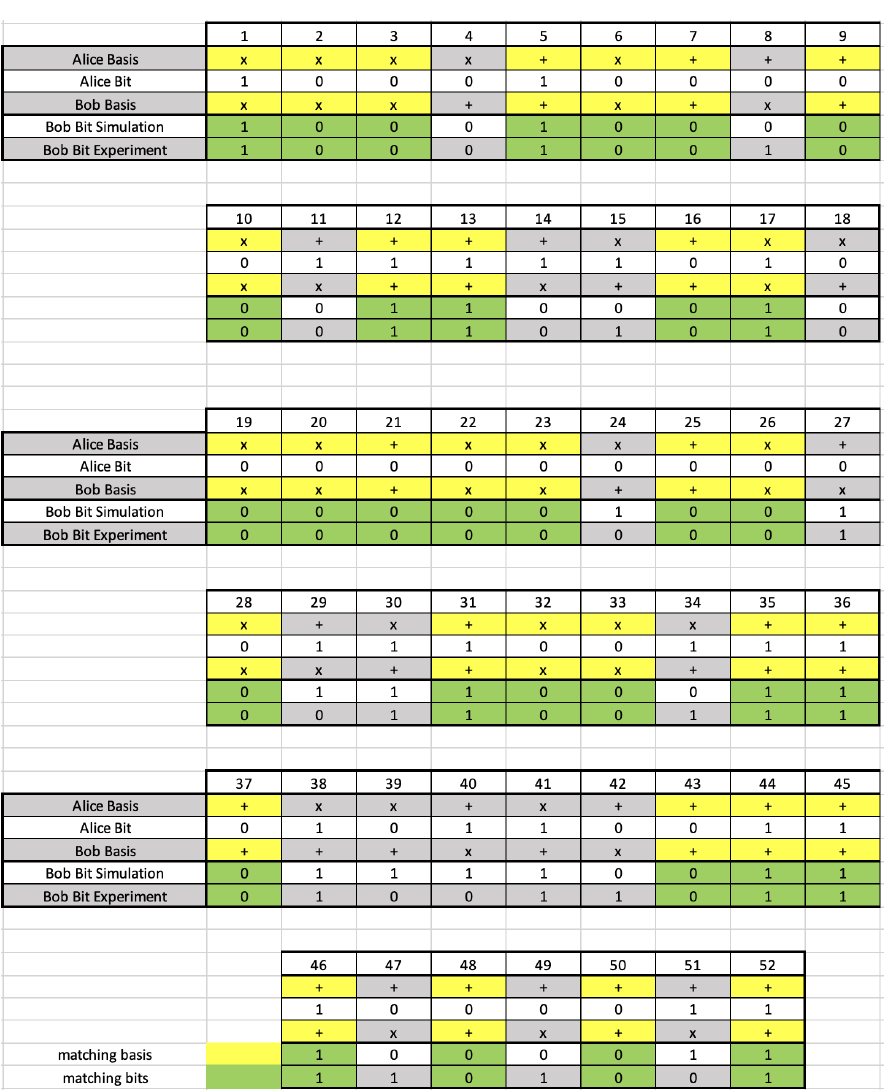
Figure A1. 18 bit key distribution results—Alice & Bob.